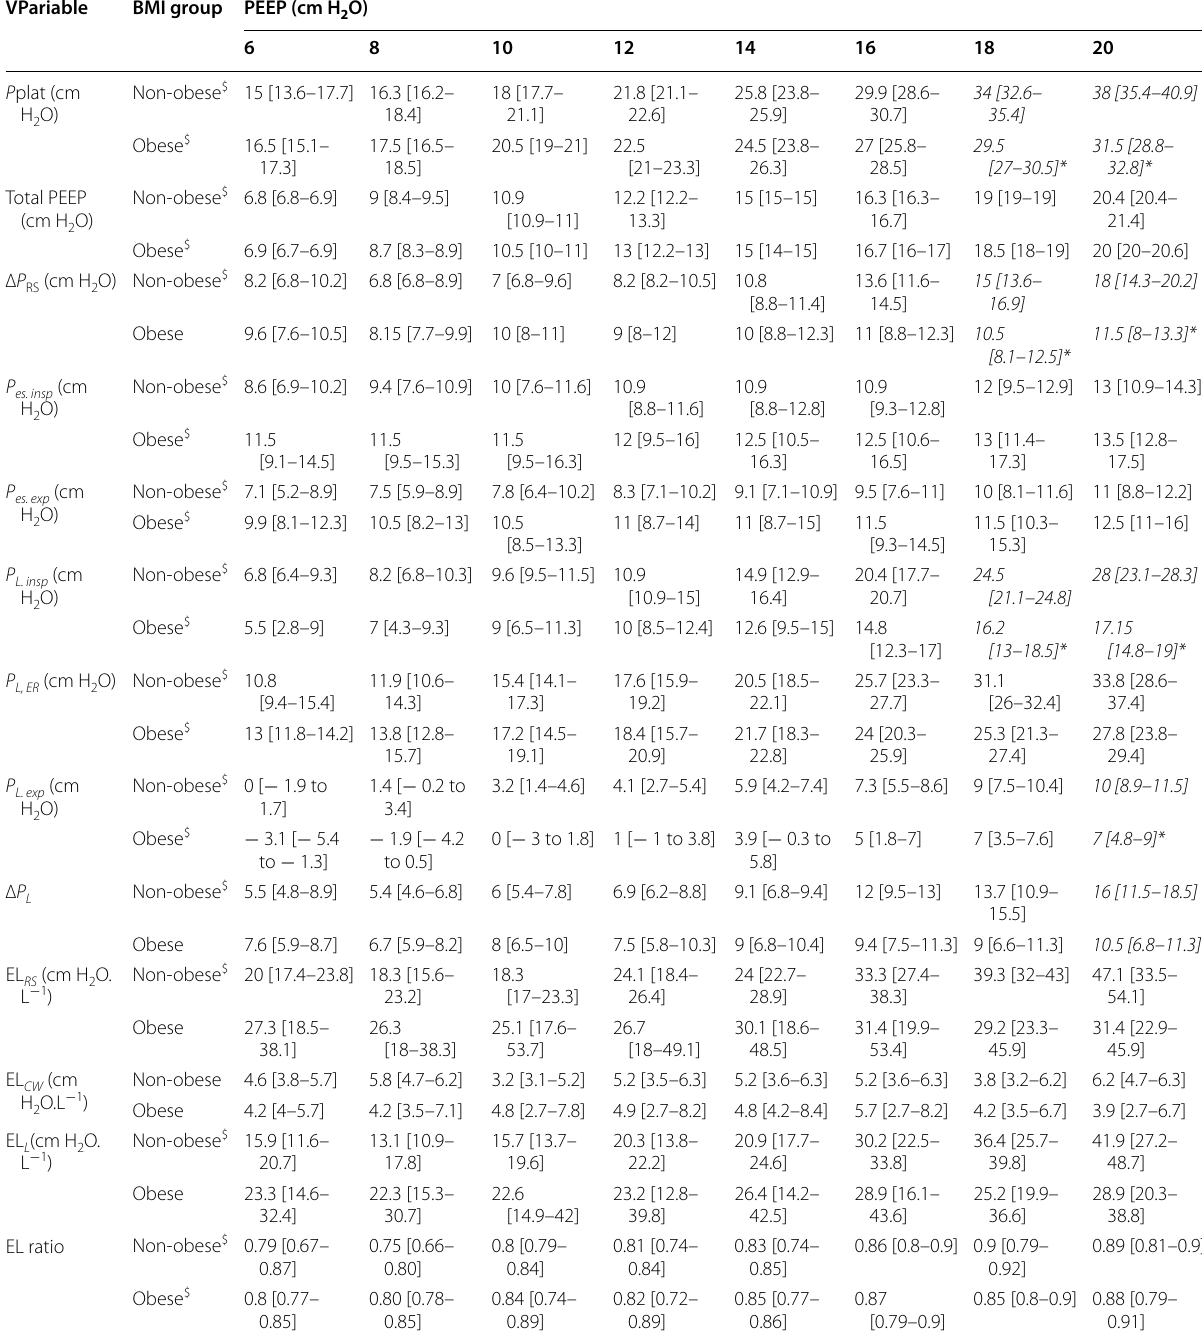
Table 1 Respiratory mechanics according to BMI group and PEEP